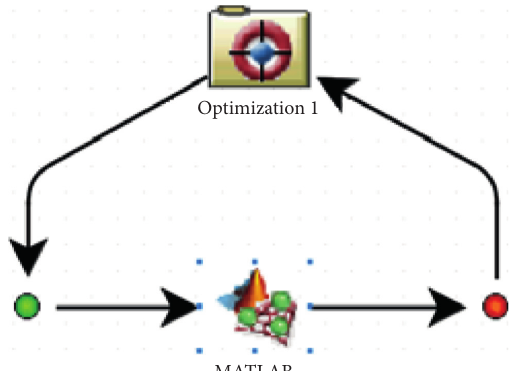
Figure 2: Isight workflow.